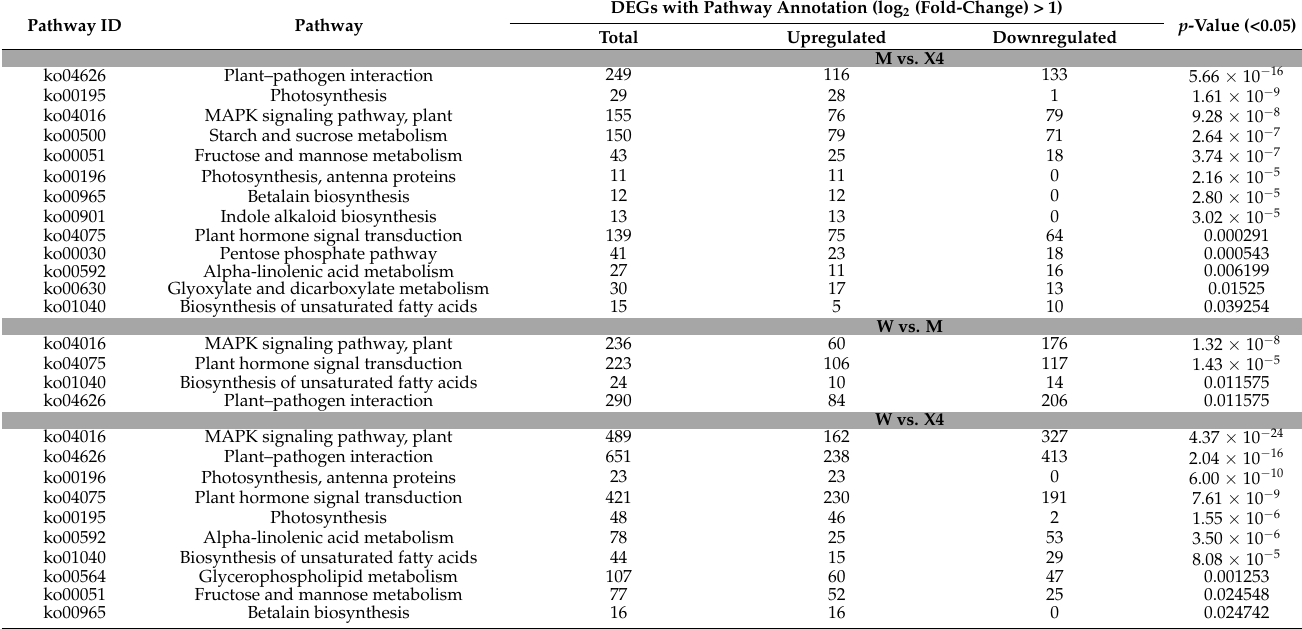
Table 2. Significantly enriched pathways of DEGs among W, M, and X4 samples through KEGG enrichment